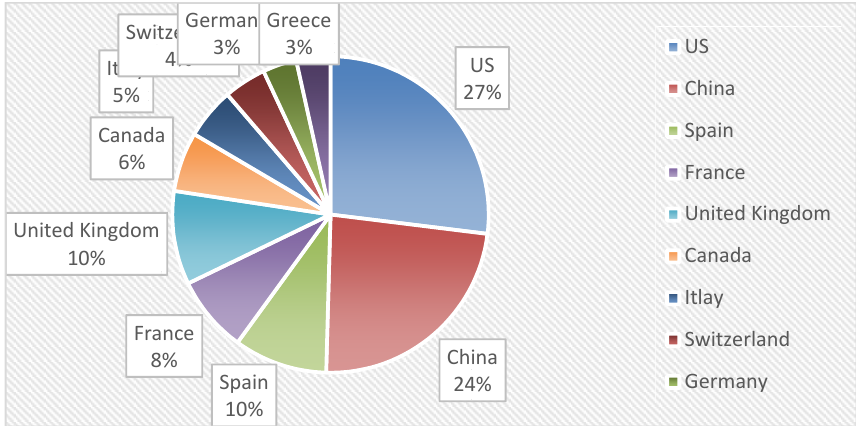
Fig. 2: Geographic distribution of pollution studies